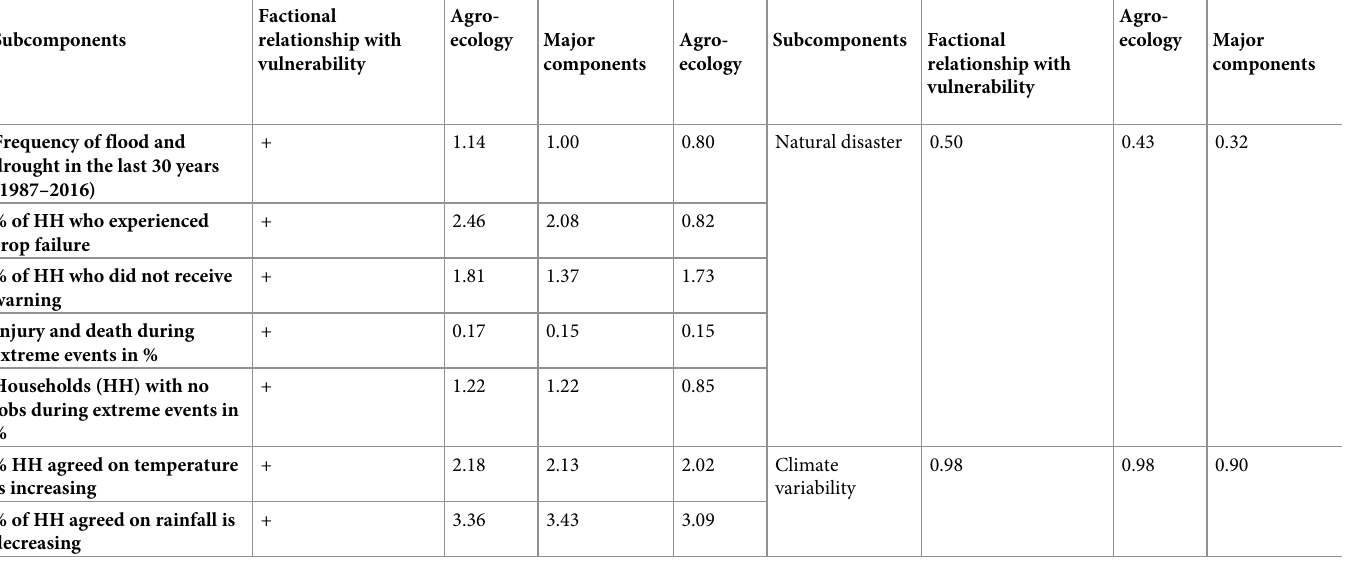
Table 5. Major components’ scores, indicator index, and weighted average of Exposure